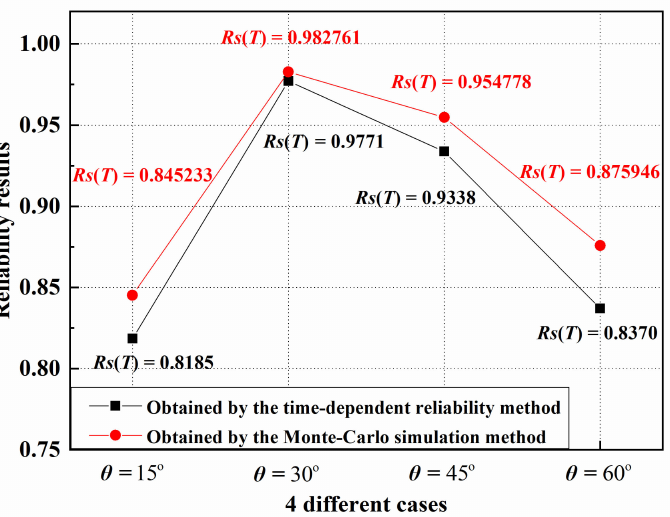
Figure 10. The reliability results comparison of the composite laminates plate between the proposed method and the Monte Carlo